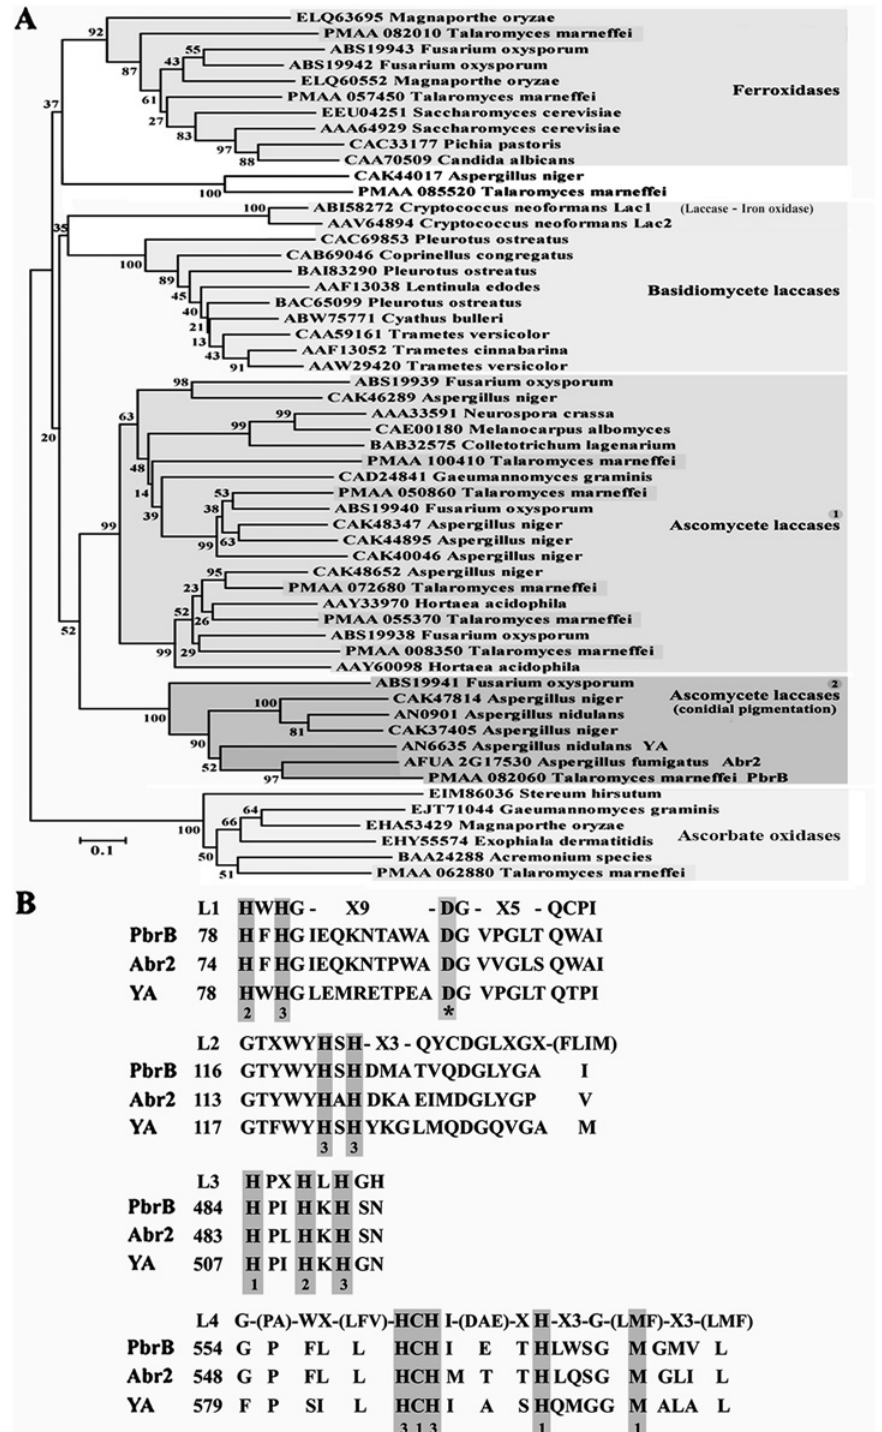
Fig 2. Phylogenetic analysis and partial sequence alignment. (A) Putative fungal MCO sequences from a number of species, including those predicted in T . marneffei , were obtained from Genbank (http://www.ncbi. nlm.nih.gov/protein/) and used to build sequence alignments in CLUSTALW. The alignment was then used to construct a relatedness tree using MEGA 6 software. Phylogenetic relationships of the 55 MCOs were inferred using the Neighbor-Joining method and bootstrap tested (1000 replicates). Branch lengths of the